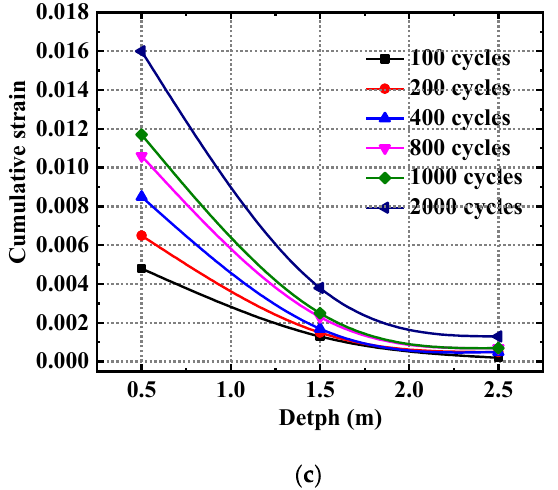
Figure 13. Cumulative strain under different loads. ( a ) Axle load = 50 kN; (b) Axle load = 130 kN; ( c ) Axle load = 240 kN.